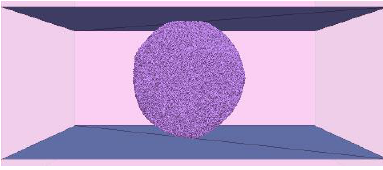
Fig. 10. LWCA single particle under uniaxial loading.